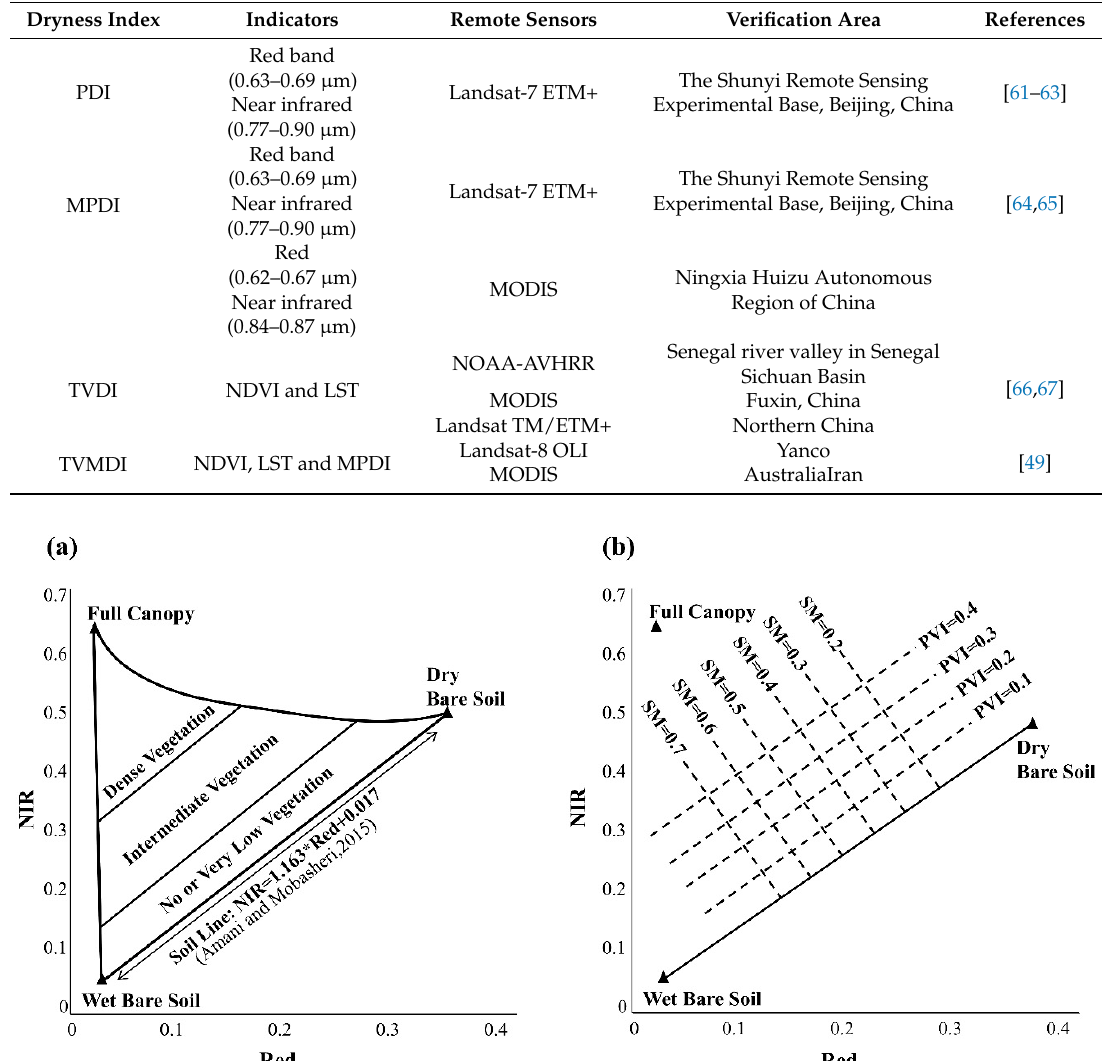
Table 3. The dryness monitoring indices based on 2/3D space.